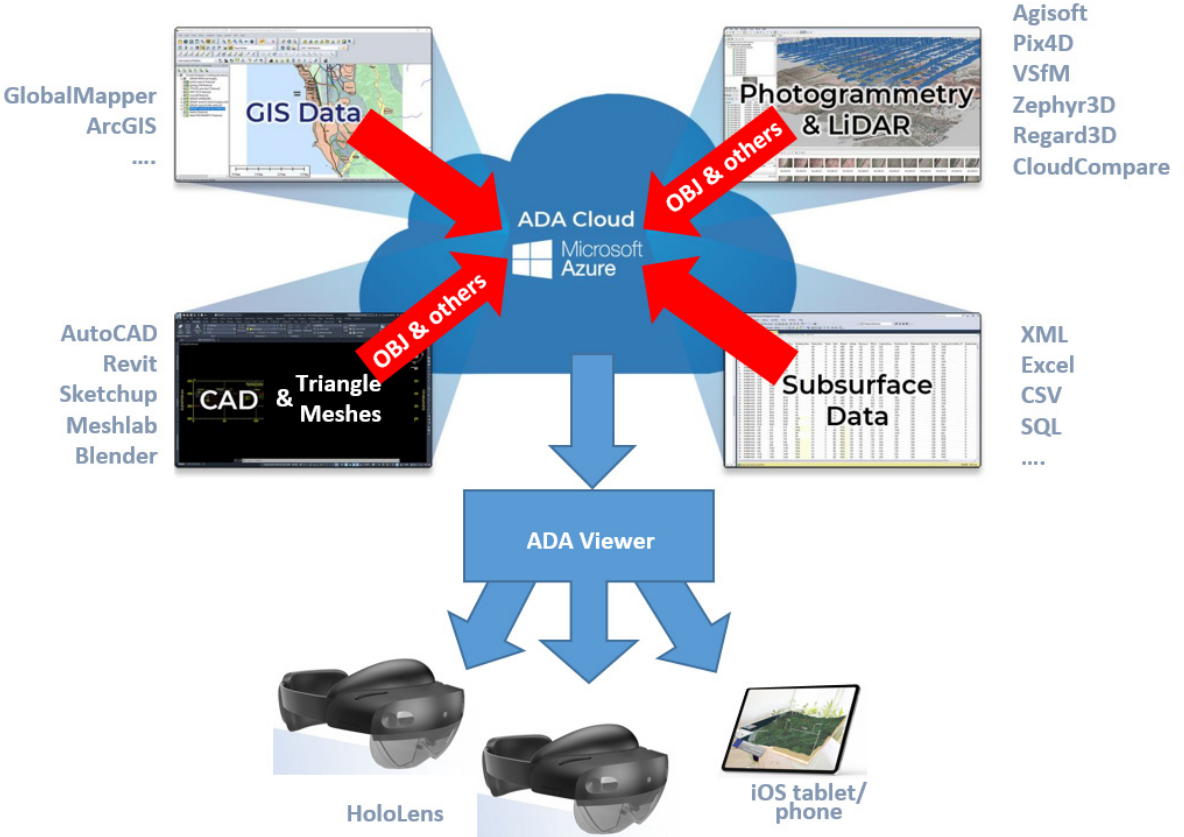
Figure 5. General workflow with the ADA Platform by Clirio: from the data acquisition to the geovisualization in HoloLens or on an iOS tablet/phone (modified from [52]).